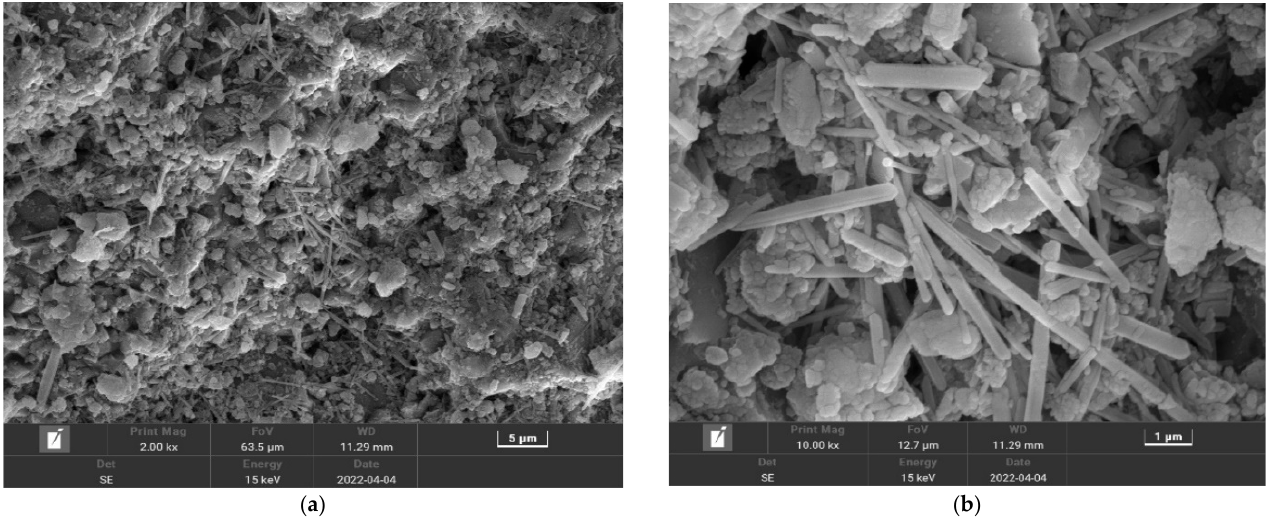
Figure 8. Microstructure of pure cement mortar: (a) 5 μ m; (b) 1 μ m.